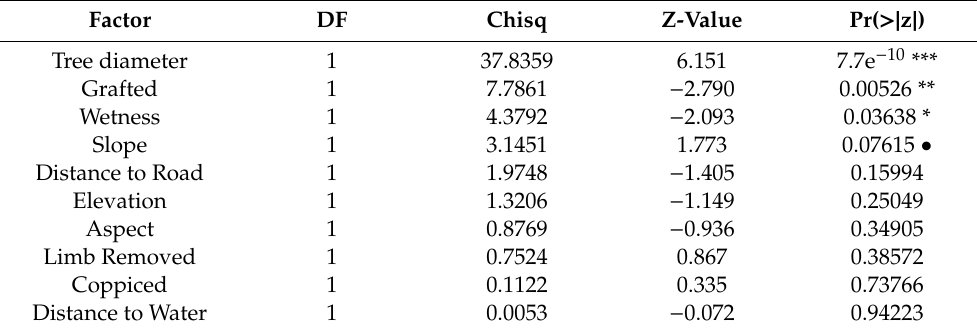
Table 2. Results of the generalized linear mixed model (GLMM) exploring the e ff ect of all factors on disease severity as a binomial high or low. Factors displayed in order of e ff ect size in Figure 4a. Significance indicated as *** representing 0, ** representing 0.001, * representing 0.01, and • representing 0.05. DF is degrees of freedom. Pr is